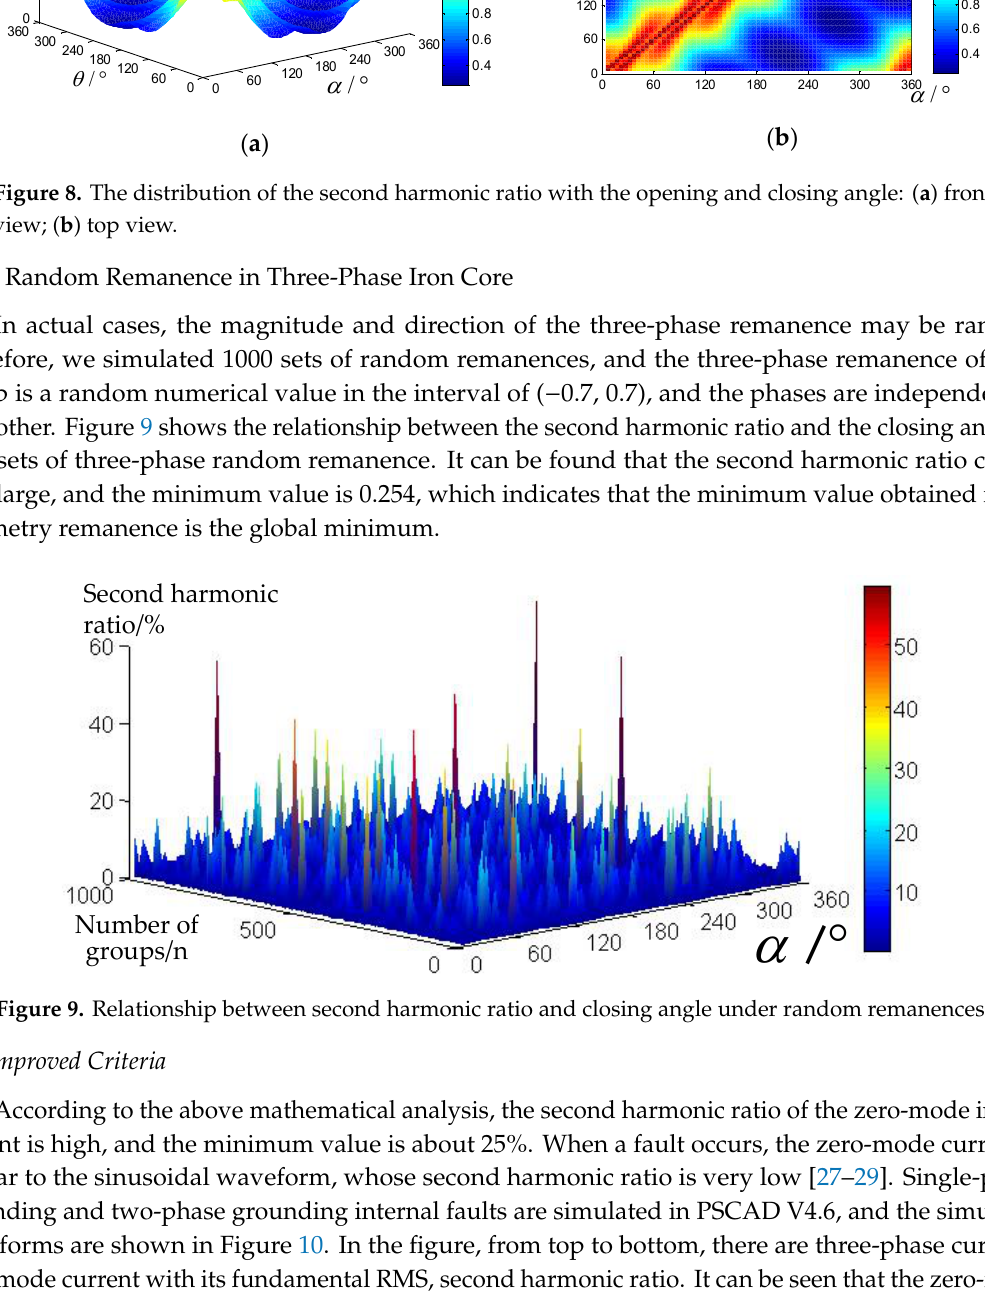
Figure 7. The distribution of the second harmonic ratio with the closing angle when the three-phase remanence is zero.